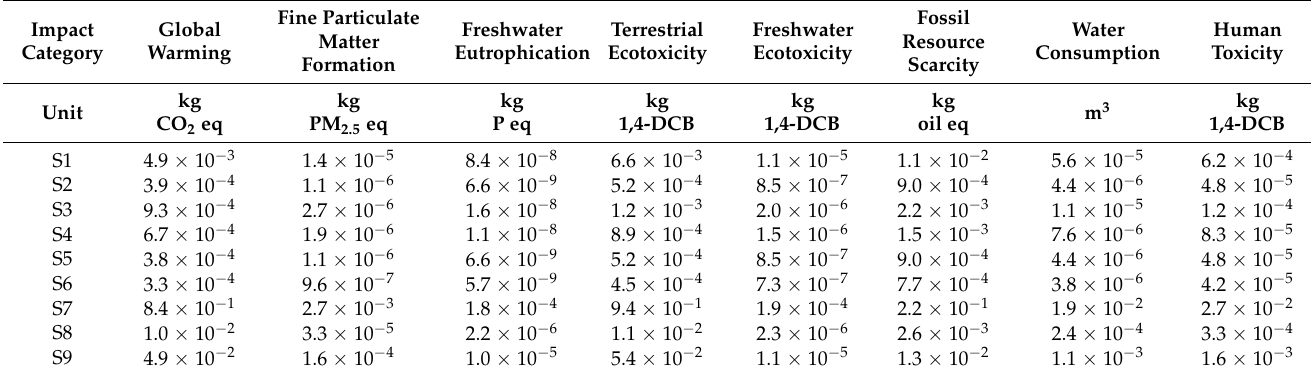
Table 3. Life cycle impacts per kg of pellets/briquettes from all process stages.